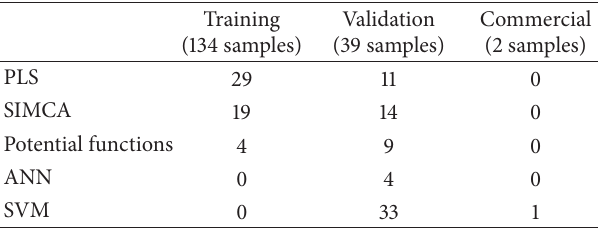
Table 7: Low concentration: classification errors using 176